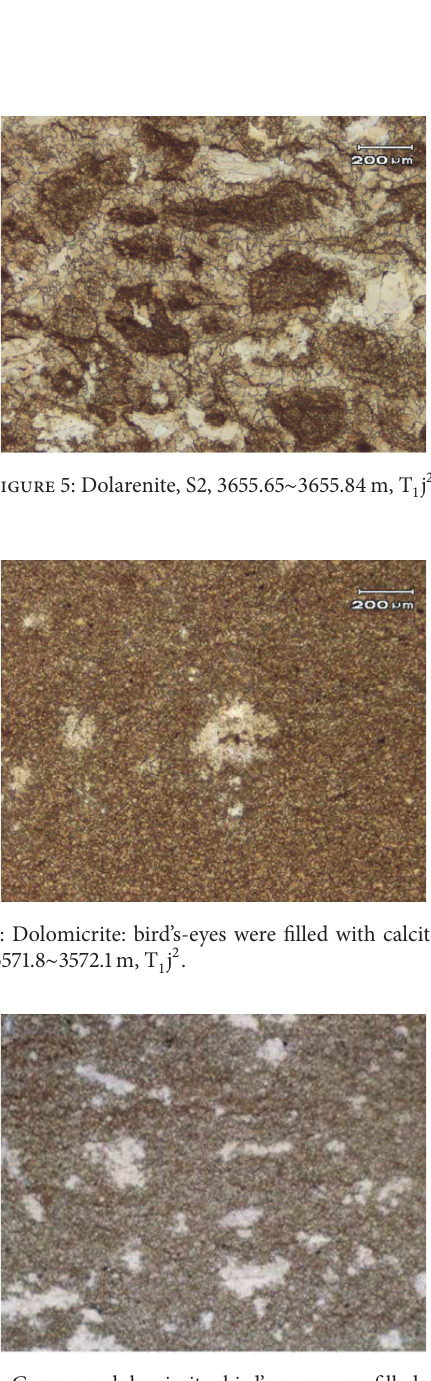
Figure 7: Gypseous dolomicrite: bird’s-eyes were filled with gyp- sum, S1, 3586.79 ∼ 3586.95 m, T 1 j 2